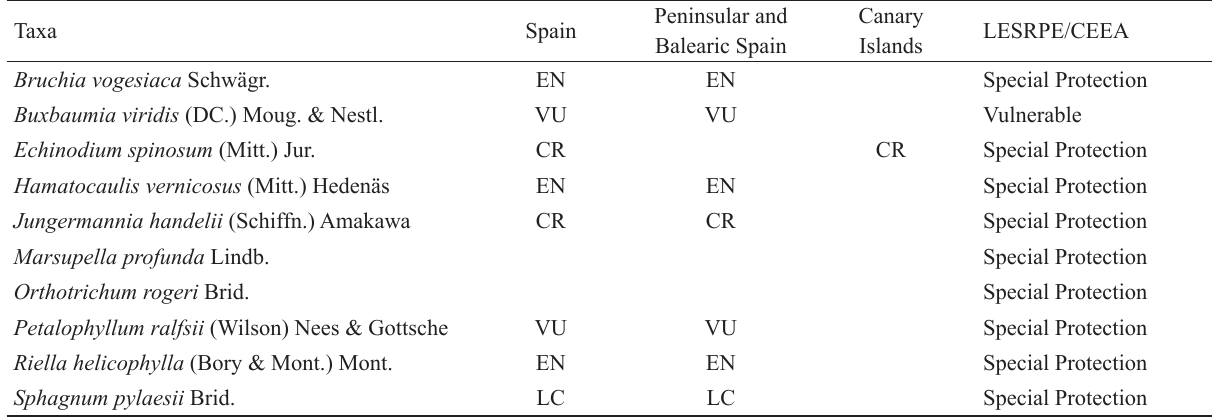
Table 2. Bryophytes included in the national catalogues for species protection, with their threat category in the Red Lists of Spain (Brugués & González-Mancebo, 2014), Peninsular and Balearic Spain (Brugués & al ., 2014) and of the Canary Islands (González-Mancebo & al ., 2013).